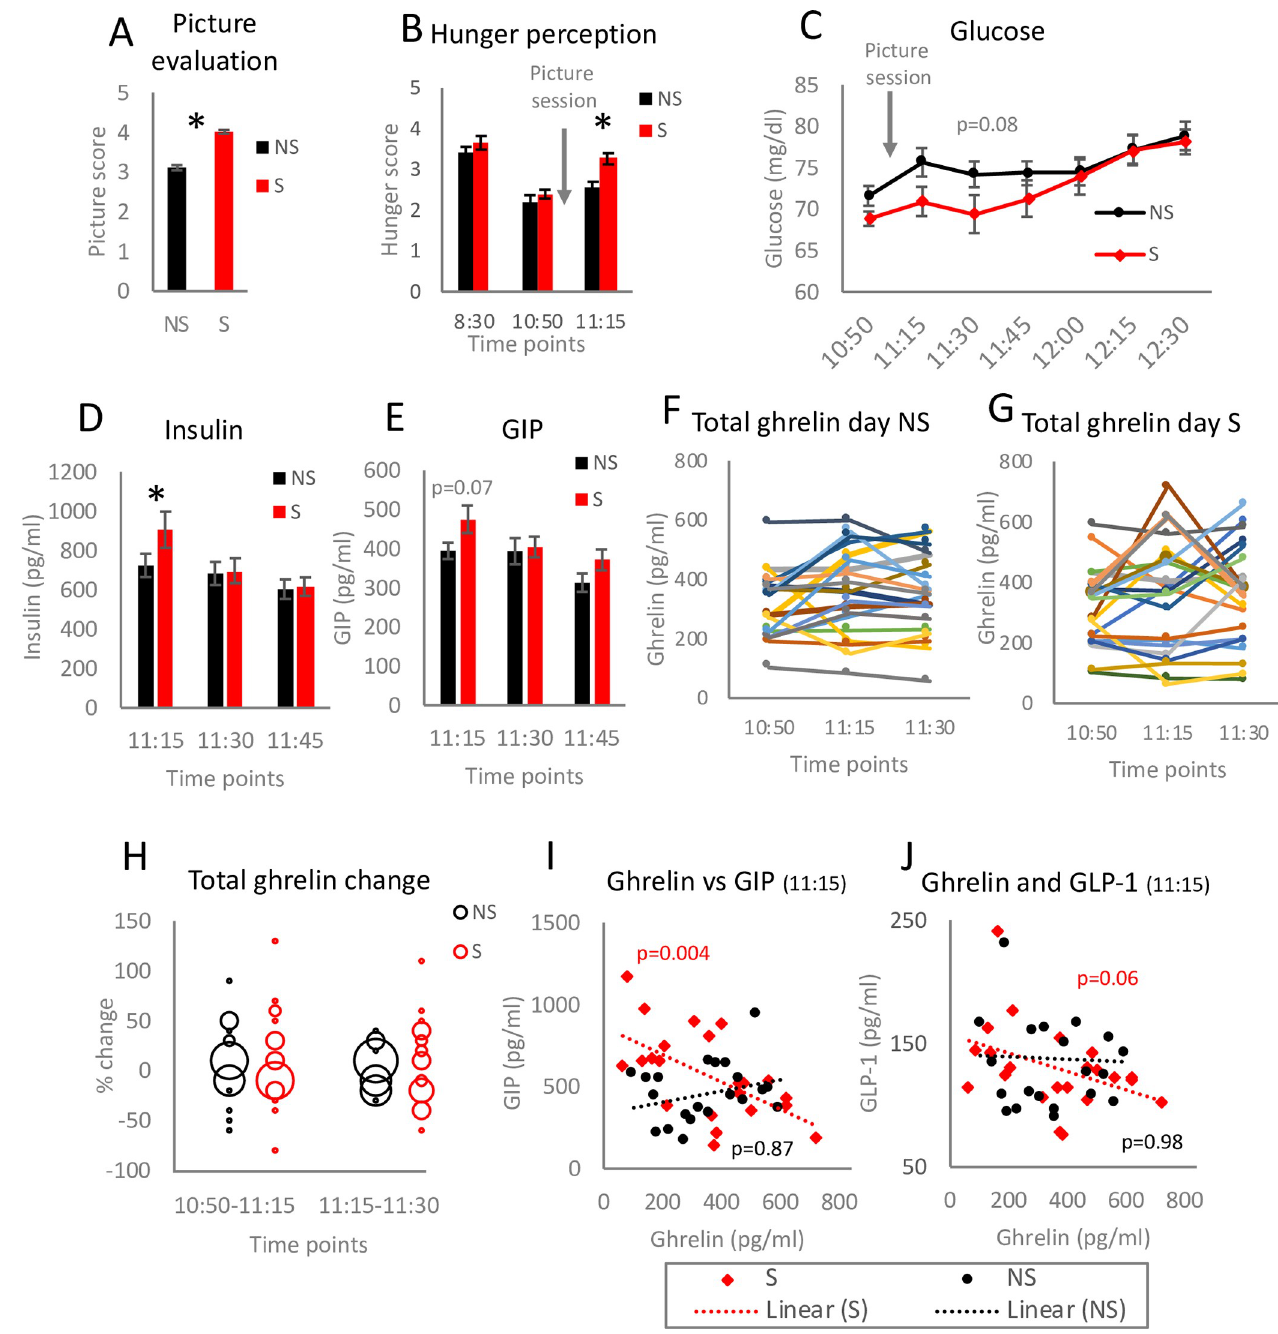
Fig 2. Food cues affect blood glucose and appetite-replated peptides. The participants rated different aspects of the pictures on a scale 1–5 (A). Hunger level was reported on a scale 1–5 by the participants at the indicated time points (B). Glucose levels were measured at all blood sampling time points (C). Insulin (D) and glucose-dependent insulinotropic peptide (GIP) (E) concentrations were quantified in blood collected at the indicated time points. For panel A statistical significance was analysed using two-tailed Student’s t-tests. Data (A-E) are presented as the mean ± SEM; � p < 0.05. For panels D-E ANOVA with Bonferroni correction for multiple testing was applied. Total ghrelin levels were measured in the samples collected on NS (F) and S (G) day of the study. Each line represents one participant. Distribution of total ghrelin concentration changes was evaluated by comparing % difference between two indicated time points (H). Linear regression analysis was performed to verify the correlation between ghrelin and GIP (I) as well as ghrelin and glucagon-like peptide-1 (GLP-1) (J) for blood samples collected at 11:15; n = 23.